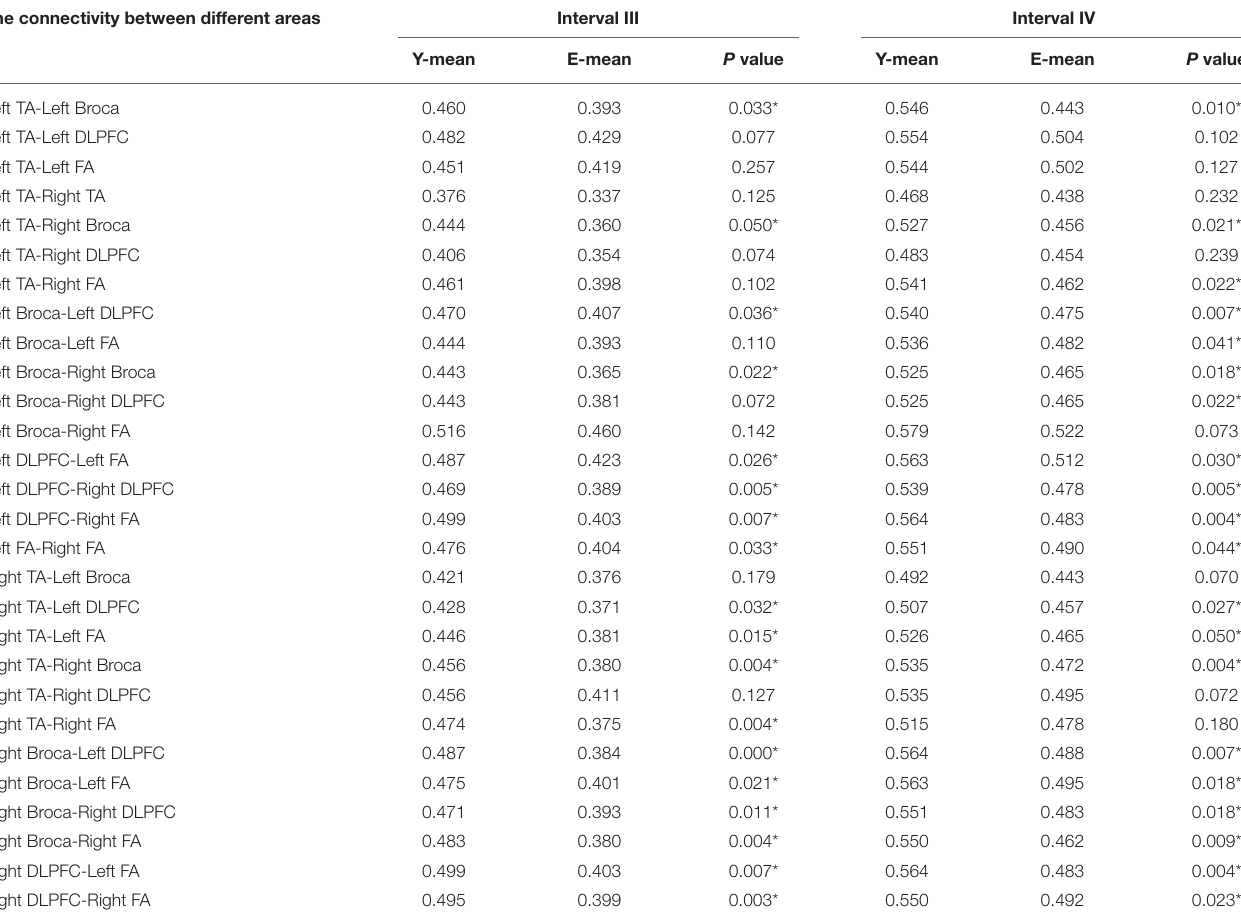
TABLE 2 | The mean connection strength between different brain areas in intervals III and IV of young and elder people. The connectivity between different